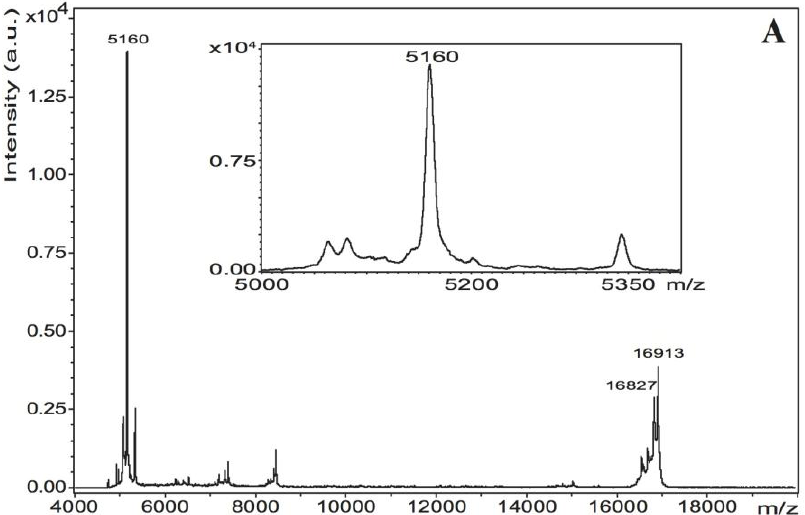
Figure 3. MALDI spectra of ( A ) pure EMD; ( B ) TiZr EMD and ( C ) Ti EMD. All graphs include an enlarged version of the region between 5000 and 5400